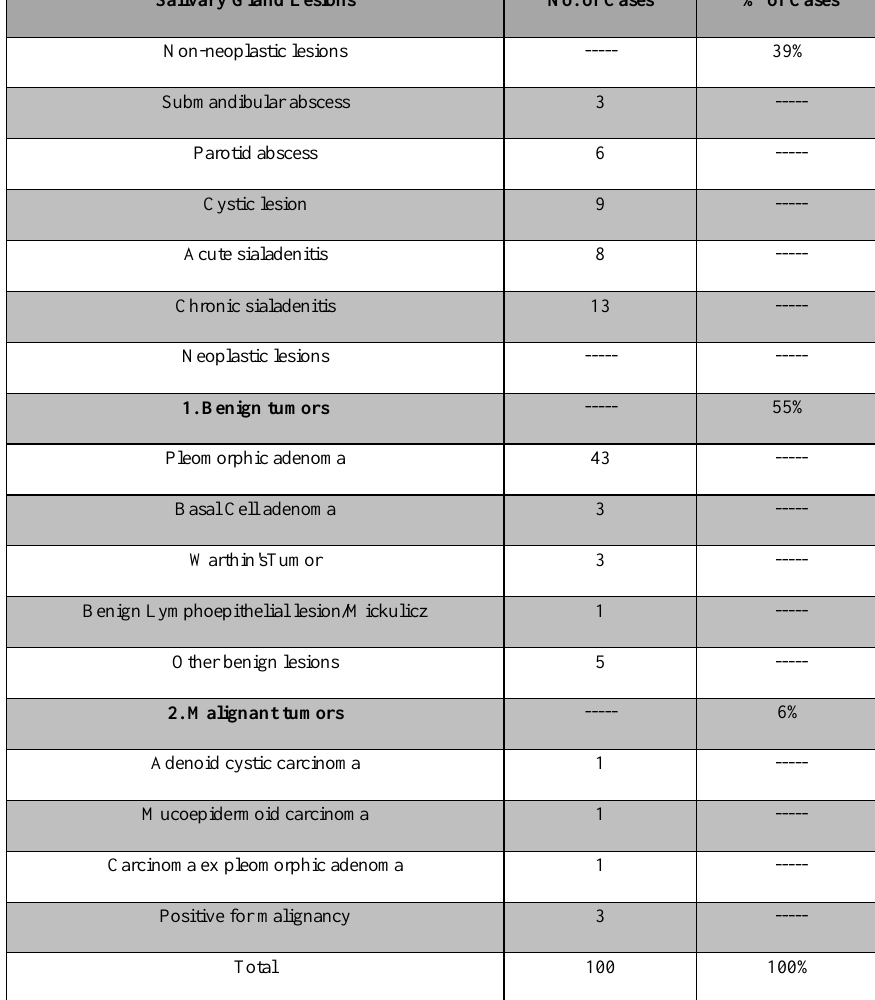
Table 3. The cytological spectrum of salivary gland lesions (n=100). Salivary Gland